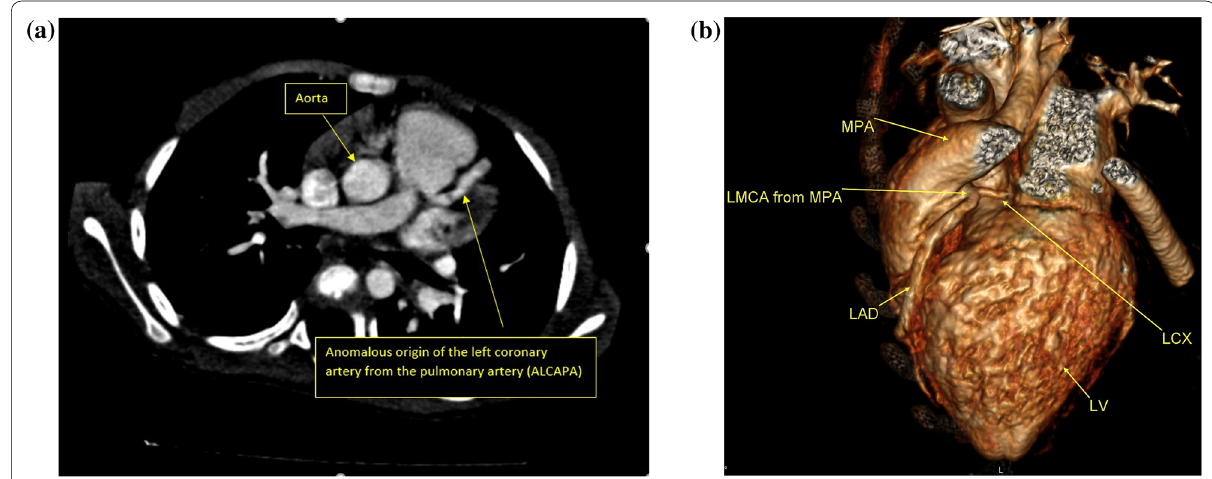
Fig. 6 a Multiplanar axial image showing anomalous origin of the left pulmonary artery from the main pulmonary artery (ALCAPA syndrome), b 3D volume rendering image showing anomalous origin of the left pulmonary artery from the main pulmonary artery (ALCAPA syndrome)